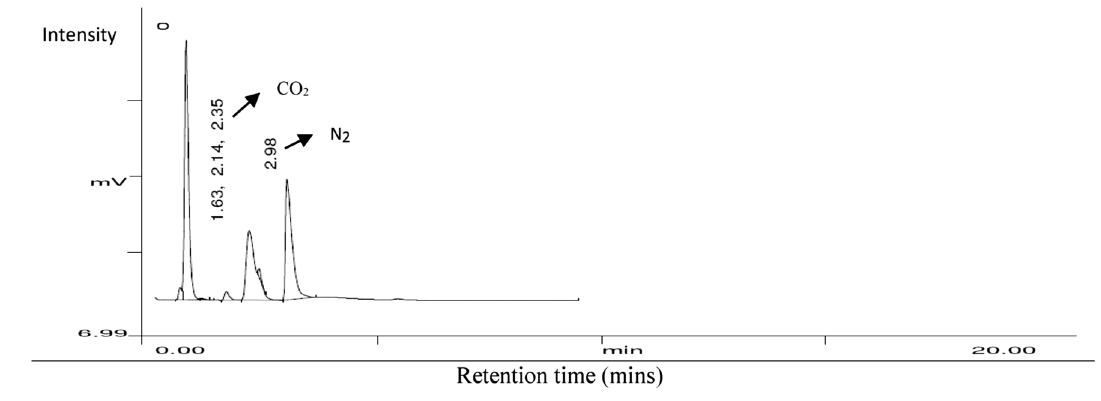
Fig. 2 GC plot of raw Belbaid coal (900 (cid:3) C)